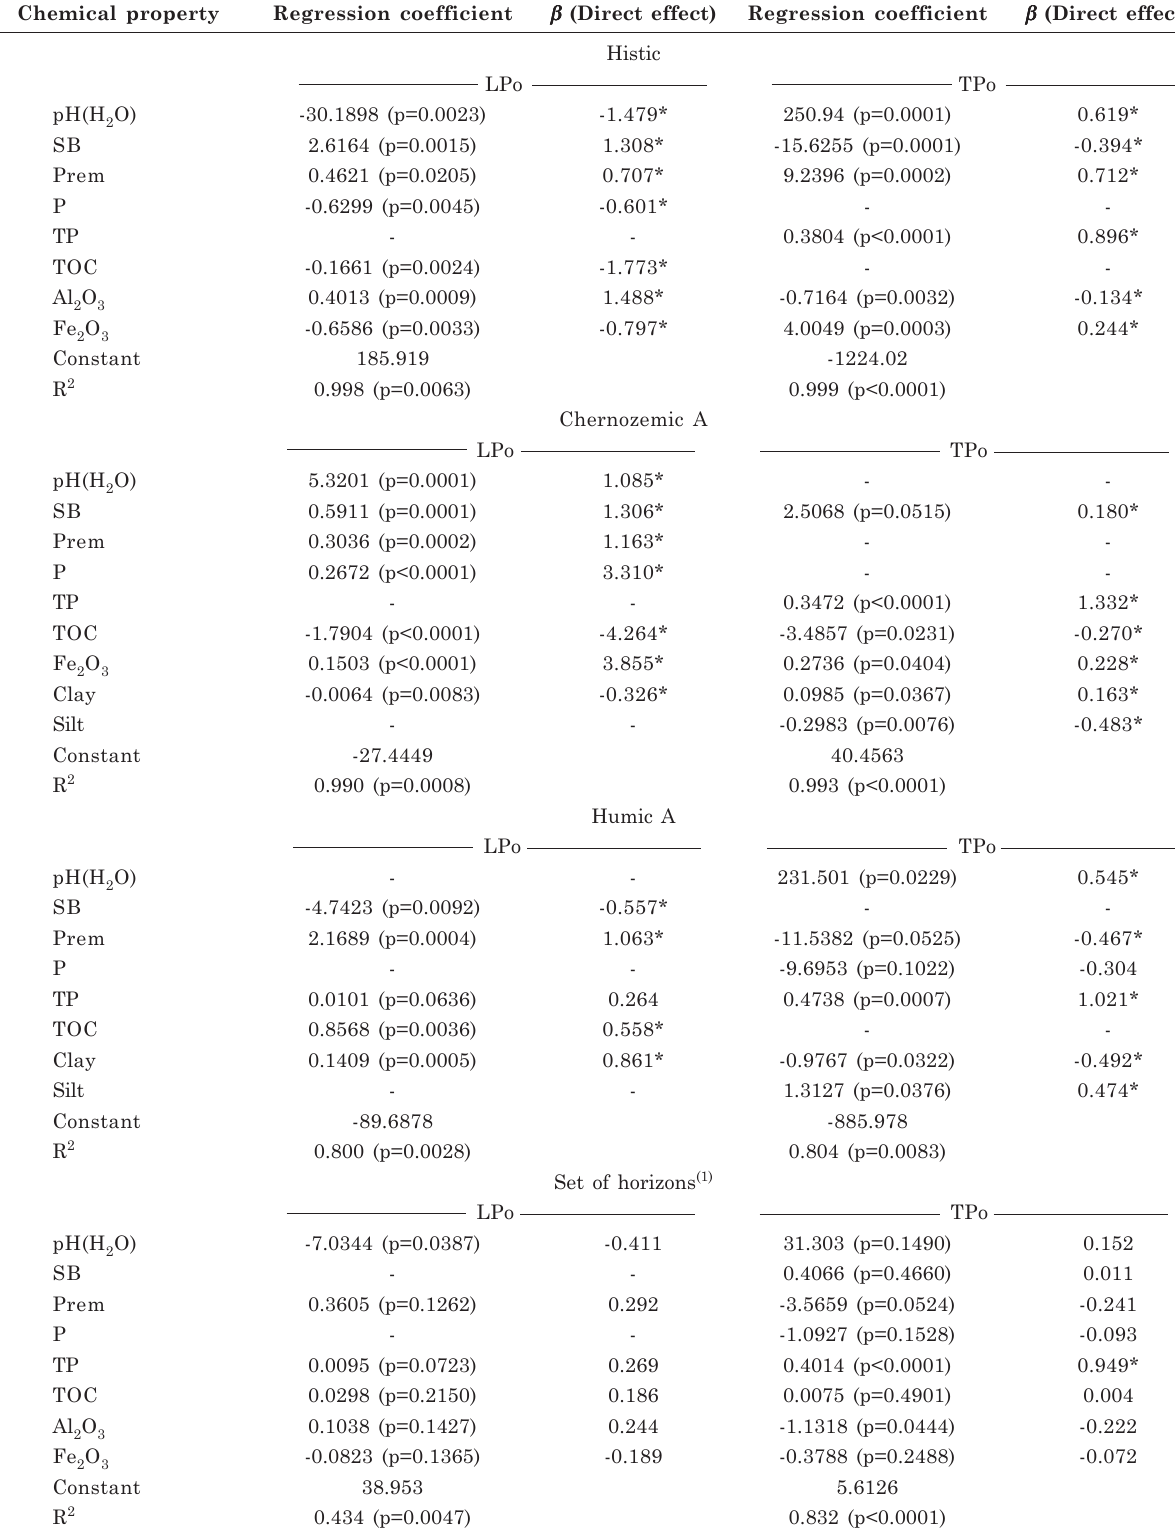
Table 6. Multiple regressions of the labile organic P (LPo) and total organic P (TPo) fractions with chemical properties and particle sizes in the surface horizons of different soil